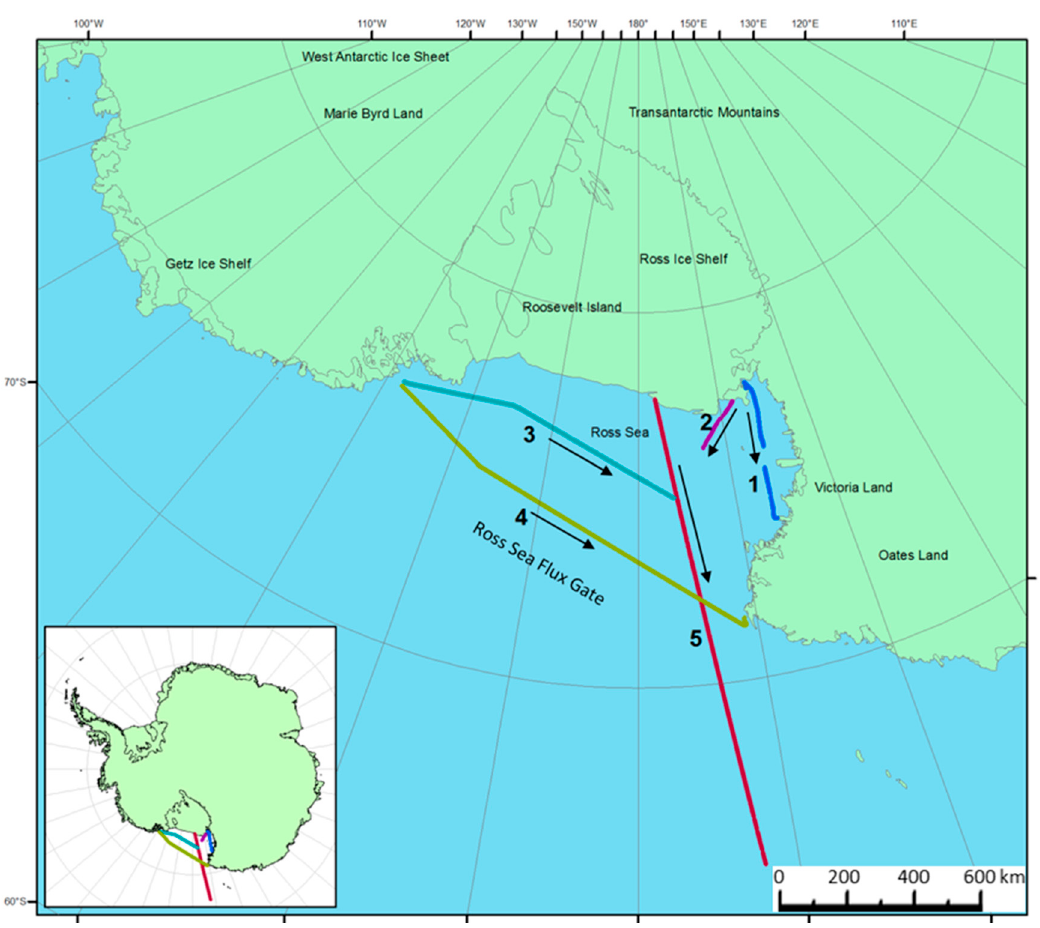
Figure 1. IceBridge flight tracks in the Ross Sea, Antarctica, on November 20 and 27, 2013. The arrows show the direction of each track that is used for data analysis and discussion purposes (adapted from [21]).